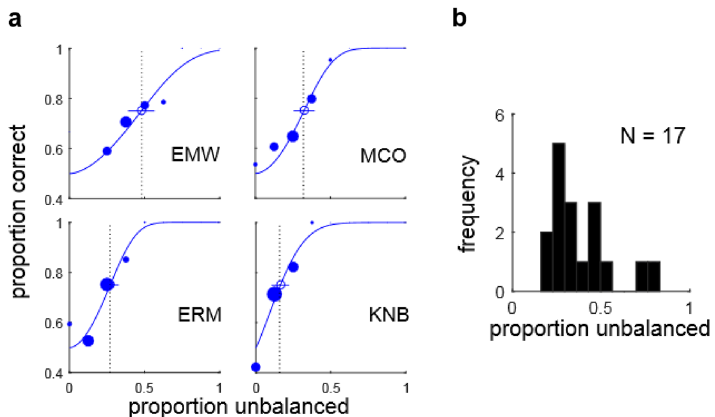
Figure 3. Psychometric functions and threshold distributions. ( a ) Psychometric functions and fitted functions based on SDT model (blue curves) for four observers (EMW, MCO, ERM, KNB) performing luminance texture boundary (LTB) segmentation (Experiment 1a) as a function of the proportion unbalanced micropatterns ( π U ), i.e. the proportion of micropatterns not having a same-polarity counterpart on the opposite side of the boundary. The size of each solid dot is proportional to the number of trials obtained at that level, and dashed black lines denote 75% thresholds for the fitted curves. Circles and lines indicate threshold estimates and 95% confidence intervals obtained from 200 bootstrapped re-samplings of the data. ( b ) Histogram of segmentation thresholds ( π U ) measured from all observers (N = 17) in Experiment 1a.